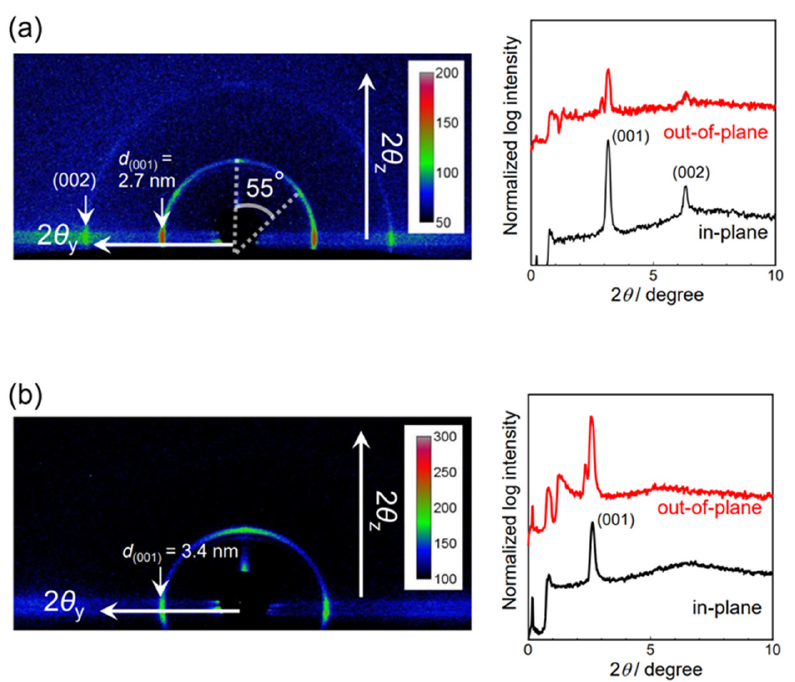
Figure 2. GI-SAXS data of PAz film sandwiched between two glass substrates at room temperature ( a ) and at 90 °C ( b ). In each part, left and right figures display 2D GI-SAXS patterns and 1D intensity profiles taken from the 2D data, respectively. In the left profiles, red and black data show the out-of-plane and in-plane directions, respectively.